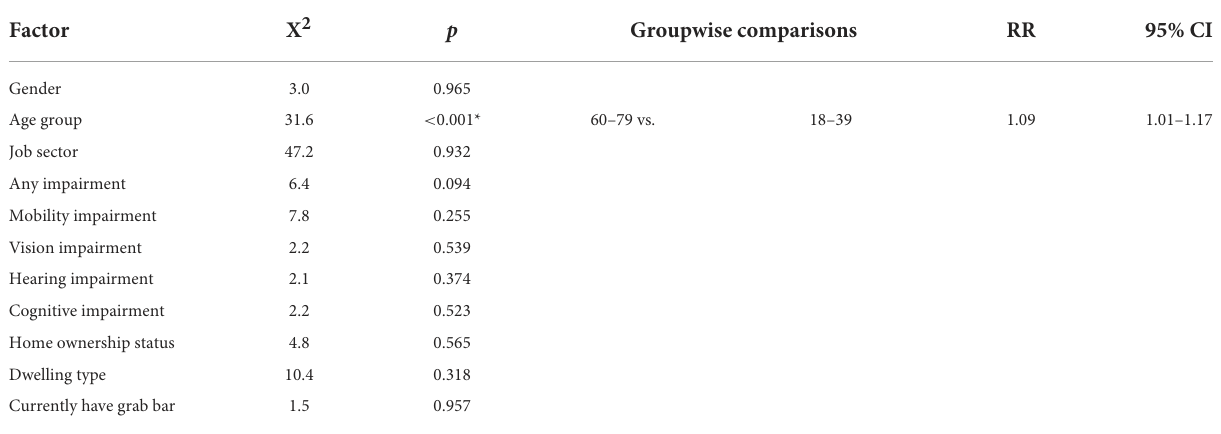
TABLE 4 Probability of allowing a grab bar at no cost (GB2): Comparison by respondent demographic characteristics, disability status and living environment. Factor X 2 p Groupwise comparisons RR 95%